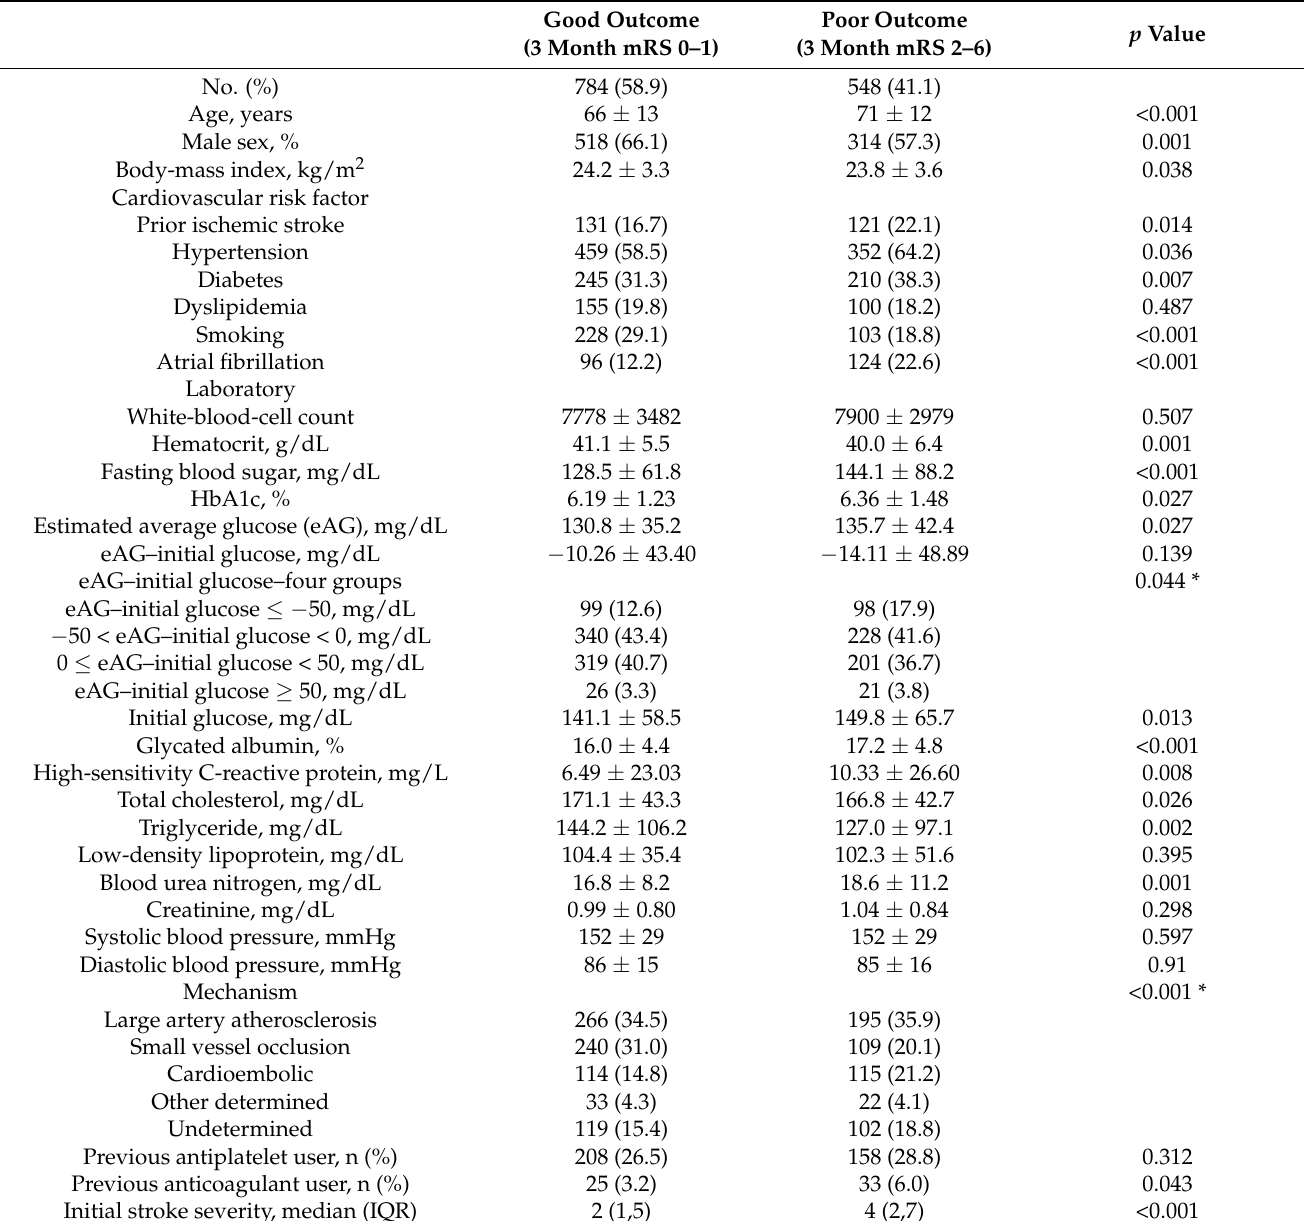
Table 1. Baseline characteristics according to initial stroke